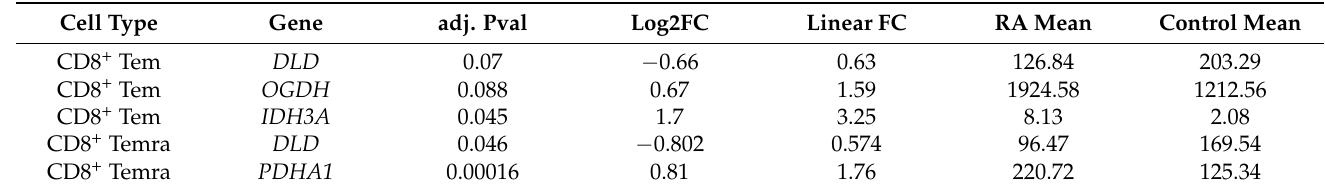
Table 8. Tricarboxylic acid cycle DEGs in untreated RA T cell subsets. Means are calculated from DESeq2 normalized counts.